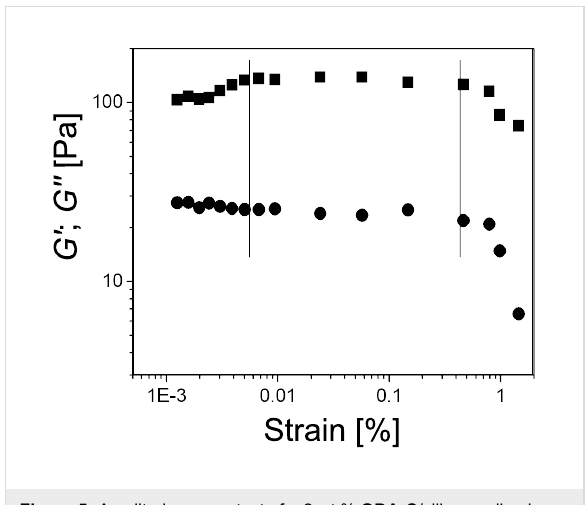
Figure 5: Amplitude sweep test of a 2 wt % ODA-C /silicone oil gel showing G ′ ( ■ ) and G ″ ( ● ). The vertical lines mark the range of the linear viscoelastic